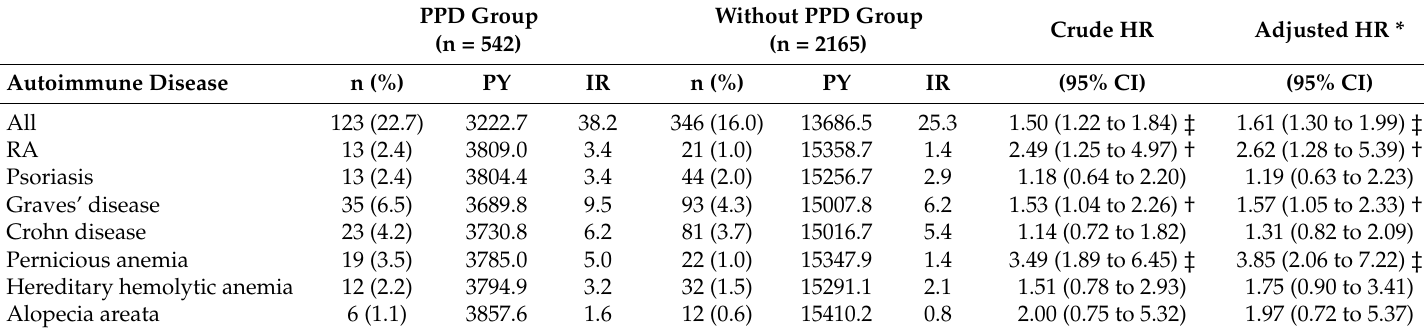
Table 2. The associations between PPD and autoimmune diseases (in which total n ≥ 5 in the PPD group) as determined by Cox regression analysis.